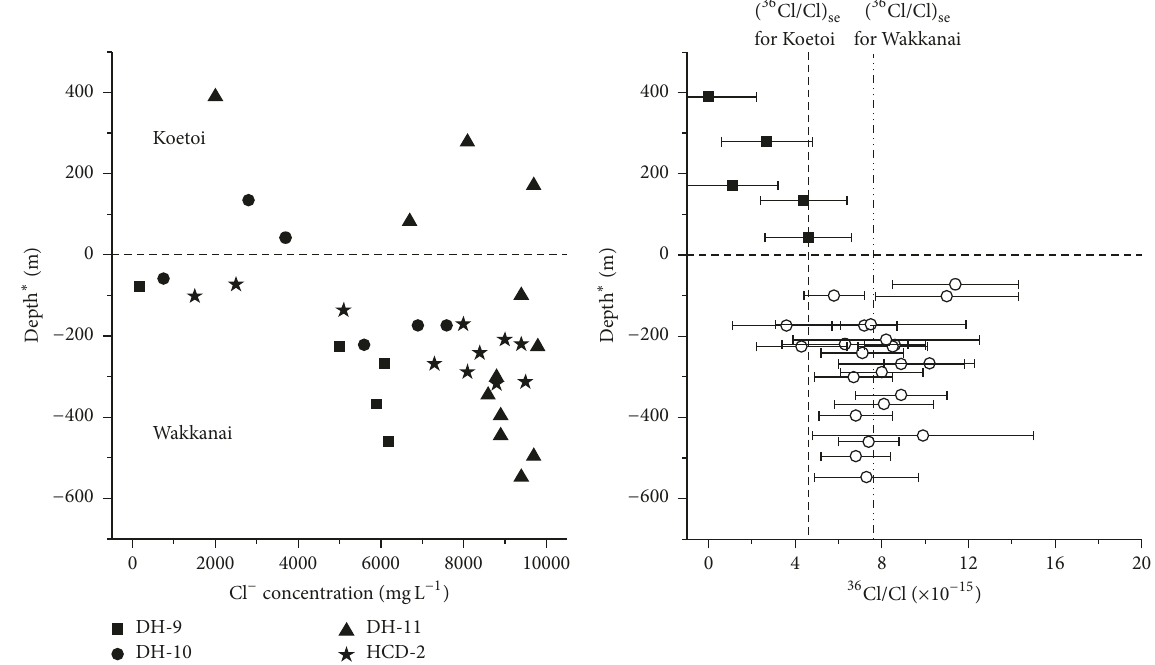
Figure 4: Depth profile of Cl − concentration 36 Cl/Cl in the Koetoi and Wakkanai formations. ∗ Depth: the boundary of the Koetoi and Wakkanai formations is indicated as 0 m, and the relative depth from the boundary is indicated by the vertical